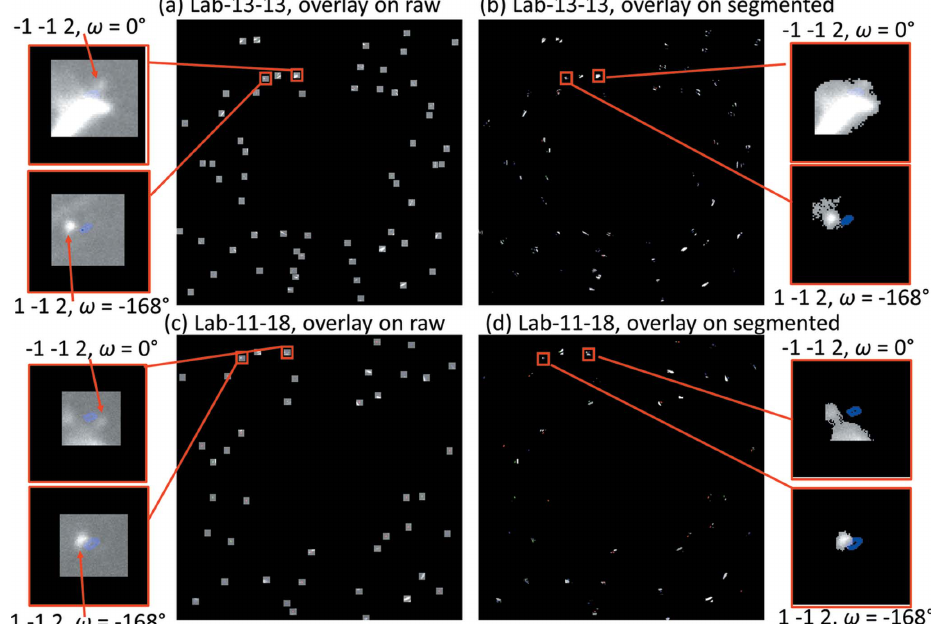
Figure 7 Overlay of forward simulated spots for grain #664 (a false-negatively indexed grain in both Lab-13-13 and Lab-11-18) onto experimental raw images and segmented images for ( a ), ( b ) Lab-13-13 and ( c ), ( d ) Lab-11-18. The forward simulation was performed from ! = (cid:8) 180 to 0 (cid:2) with a step of 4 (cid:2) . The resulting completeness for this grain is 0.37 and 0.21 for Lab-13-13 and Lab-11-18, respectively, which fall below the pre-set minimum completeness value (= 0.45). The rotation angle ! and ( hkl ) for each spot are given in the